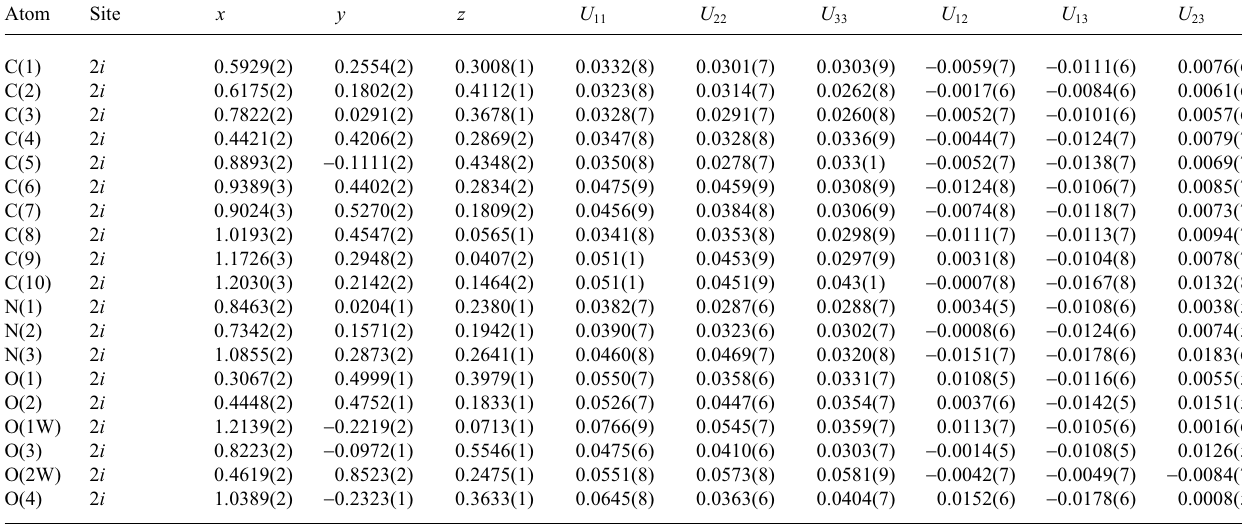
Table 3. Atomic coordinates and displacement parameters (in Å 2 ).